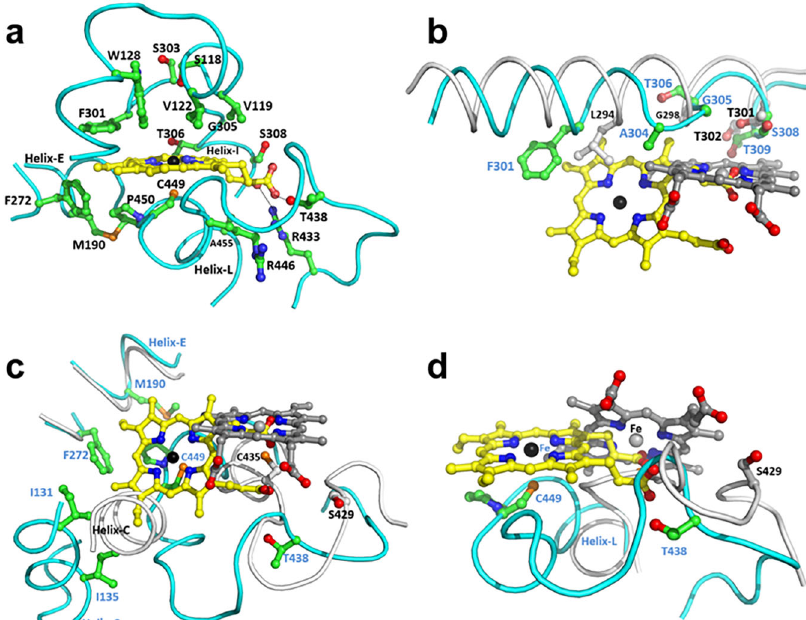
Fig. 3 The heme binding conformation of 2-HIS. a Heme molecule and its interactions with 2-HIS. b A comparison of the I-helices of 2-HIS (in cyan) and human P450 2C9 (in grey). c , d A comparison of the heme binding loop of 2-HIS (in cyan) and human P450 2C9 (in grey). The structures of heme and key residues involved in heme binding are shown as ball-and-stick models and colored according to element: oxygen, red; nitrogen, blue; sulfur, orange; iron, black for 2-HIS, and grey for P450 2C9; and carbon, green and yellow for 2-HIS residues and heme, and grey and dark grey for P450 2C9 residues and heme. The same atom color codes are used for other fi gures except ones with speci fi c descriptions. The dashed lines in Fig. 2a indicate the interactions between heme and R433 and T438.